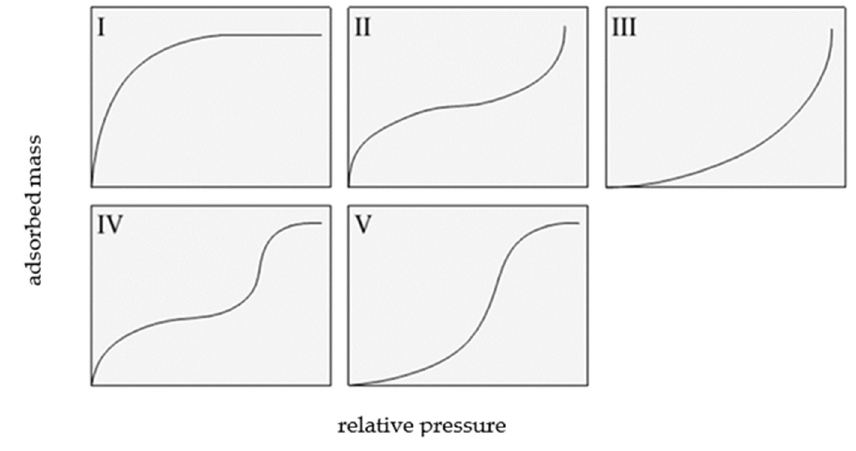
Figure 1. Types of isotherms according to Brunauer, based on [1].